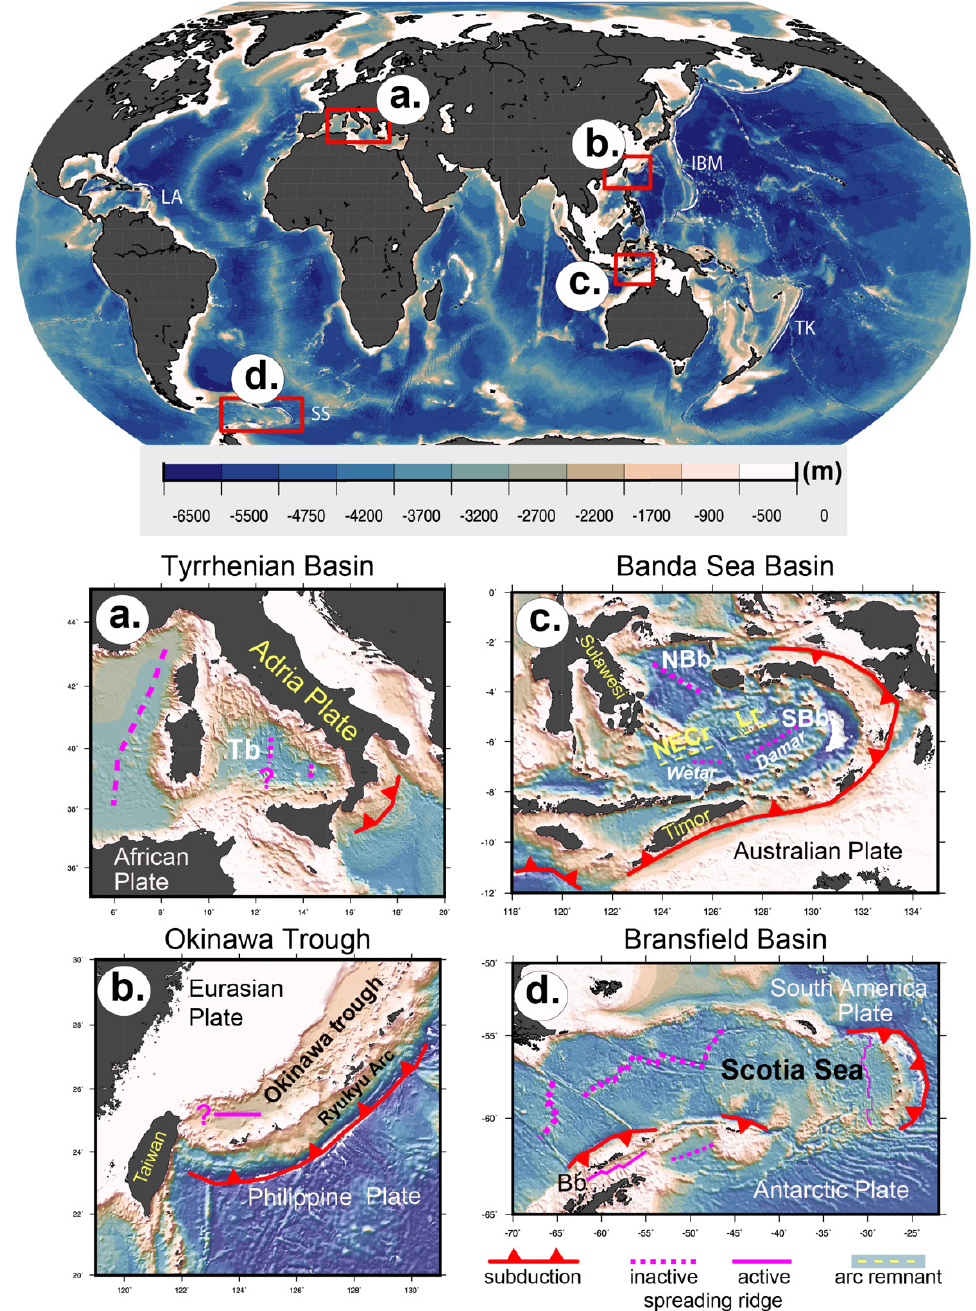
Figure 1. Natural examples of back-arc basins with ridge jumps and complex architectures described in the main text. ( a ) Tyrrhenian Basin, ( b ) Okinawa Trough, ( c ) Banda Sea Basin, and ( d ) Bransfield Basin. Question marks next to spreading ridges show the uncertainties on whether there is or has been active spreading in that region. Background image is the global bathymetry ETOPO1 [37].